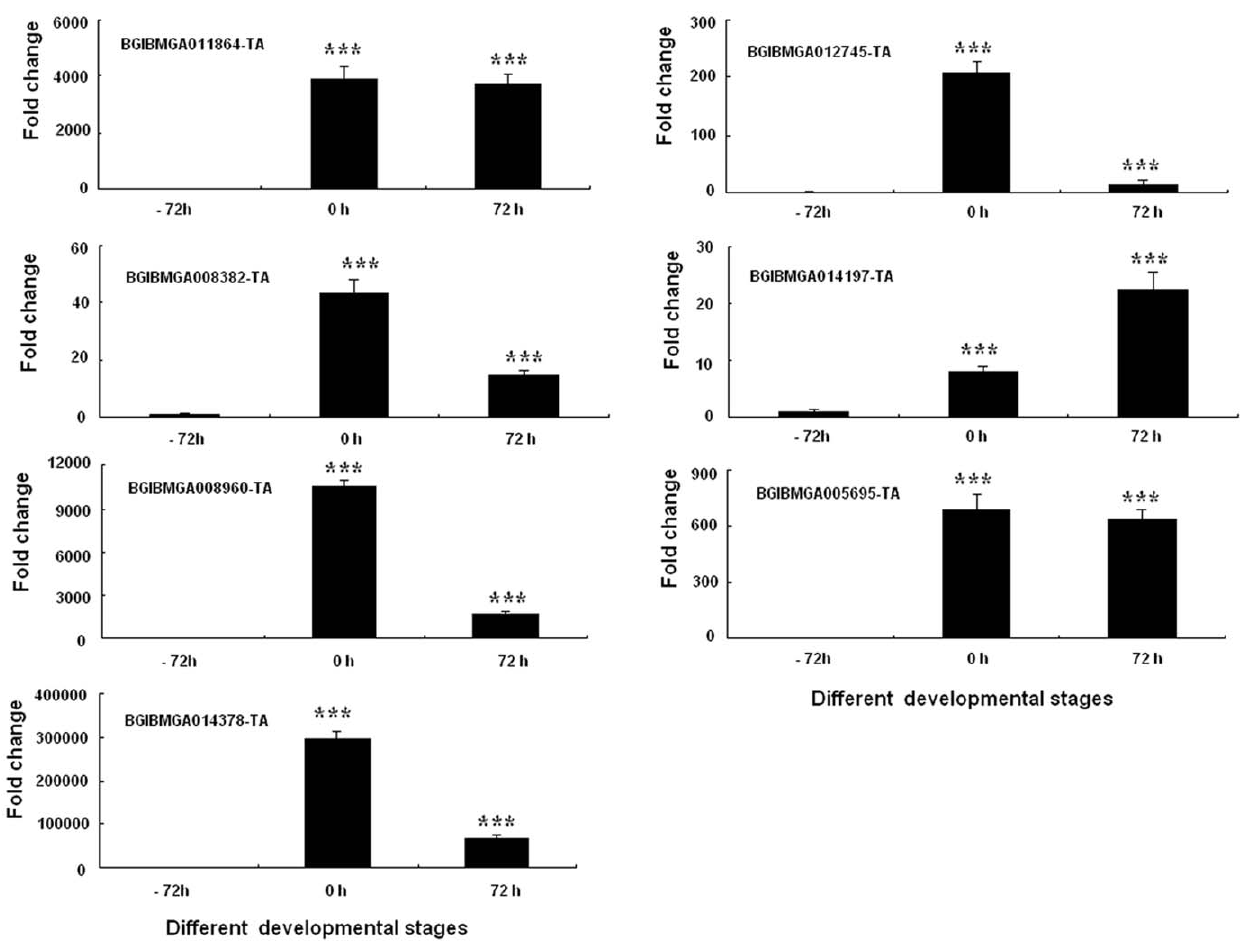
Figure 6. Differential expression of seven putative lipase genes at different developed stages. PGs were collected at different developmental stages ( 2 72, 0, and 72 h), and total RNA was extracted for real-time PCR analysis. The Rp49 gene was used as the housekeeping gene for normalization. The data represent the mean values 6 SE of three biological replicates. Significance of pairwise comparisons ( 2 72 h vs 0 h and 2 72 h vs 72 h) are marked with *** (p , 0.001) as determined by the Student’s t -test .